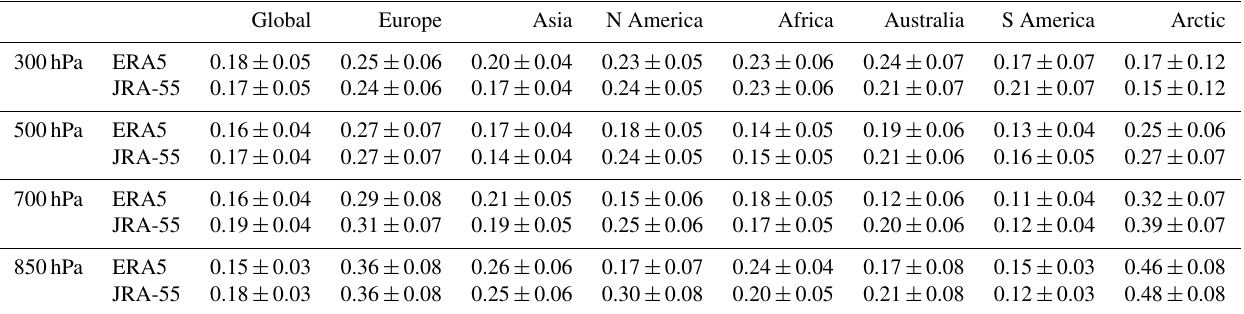
Table 2. Least squares linear trends in monthly mean temperatures (K per decade) and the ranges of 95% confidence intervals for six continental averages (as in Table 1) for the period from March 1979 to February 2022 for four pressure levels and the ERA5 and JRA-55 analyses. Global and Arctic averages are also shown. Global